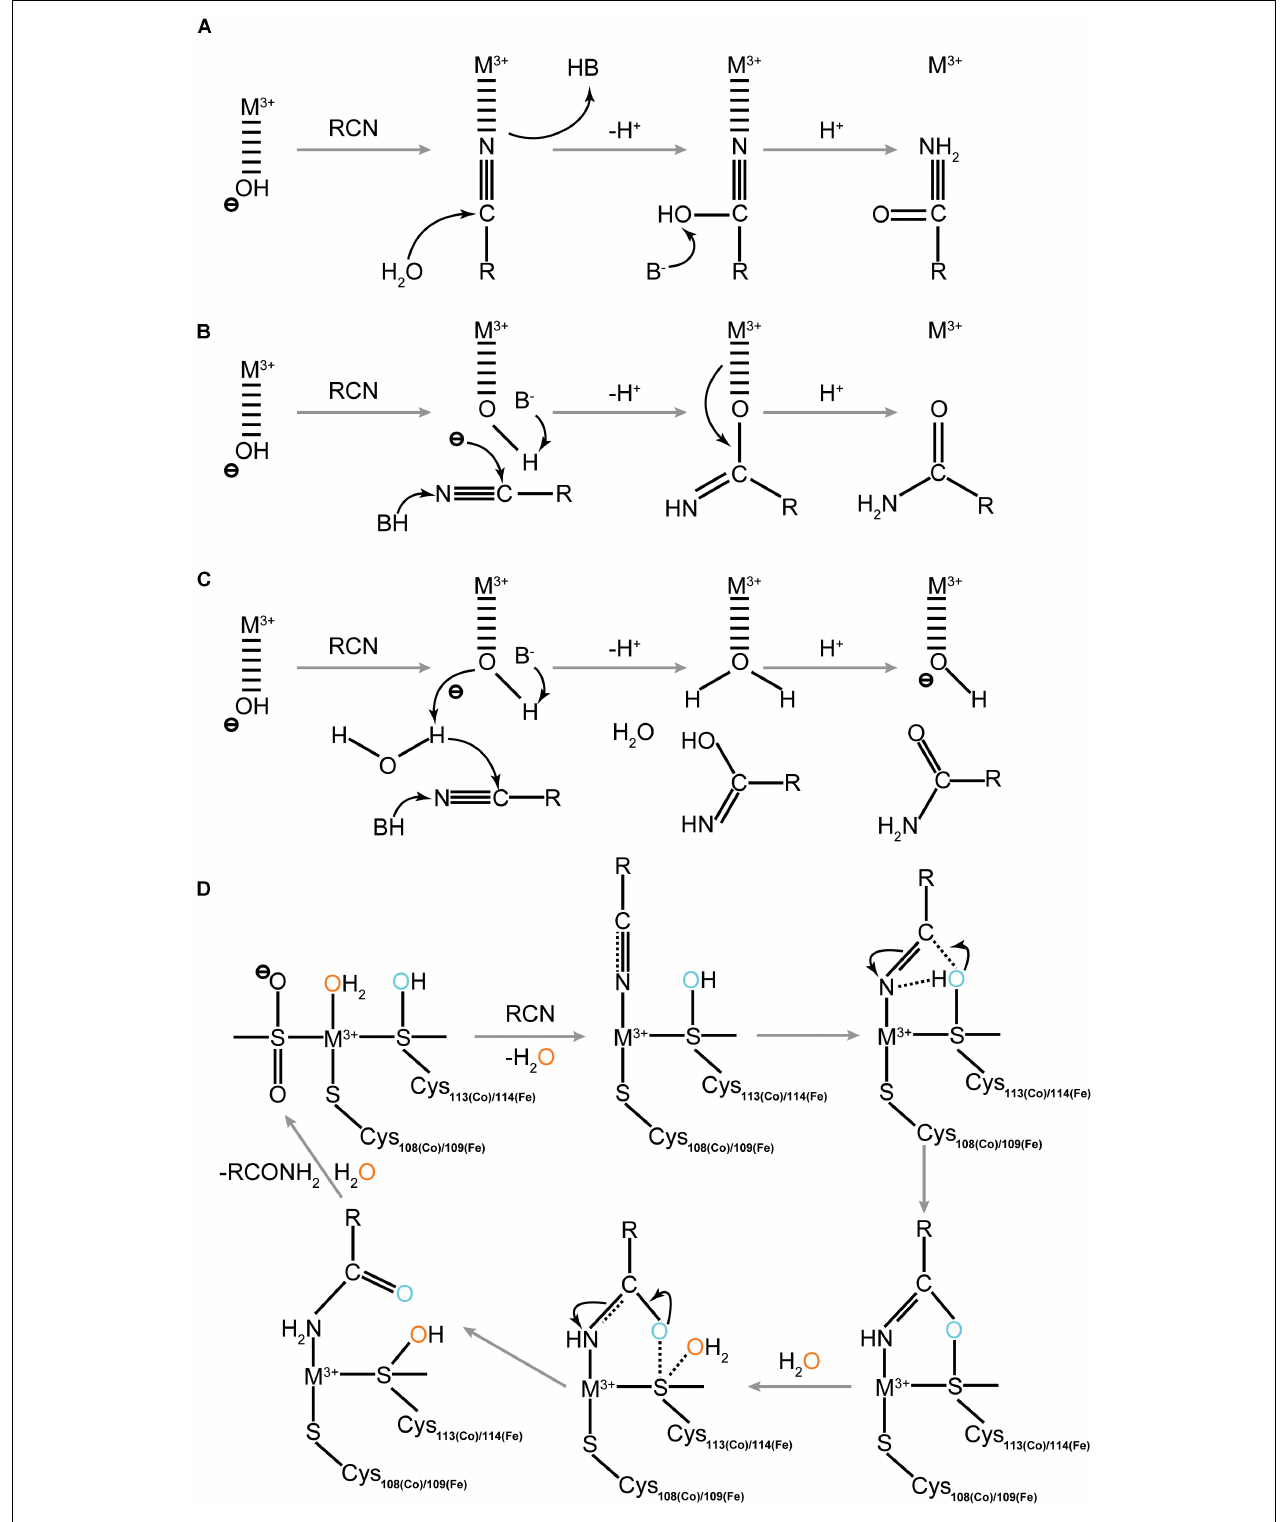
FIGURE 3 | Four proposed catalytic mechanisms for NHase catalysis. (A) The innersphere mechanism; (B) the outer-sphere mechanism; (C) the newly proposed outer-sphere mechanism (Indirectly Activated Nucleophile); (D) Direct attack of activated Sulfenate toward substrate. The blue and orange color of the oxygen atoms represent the different sources of oxygen during catalytic